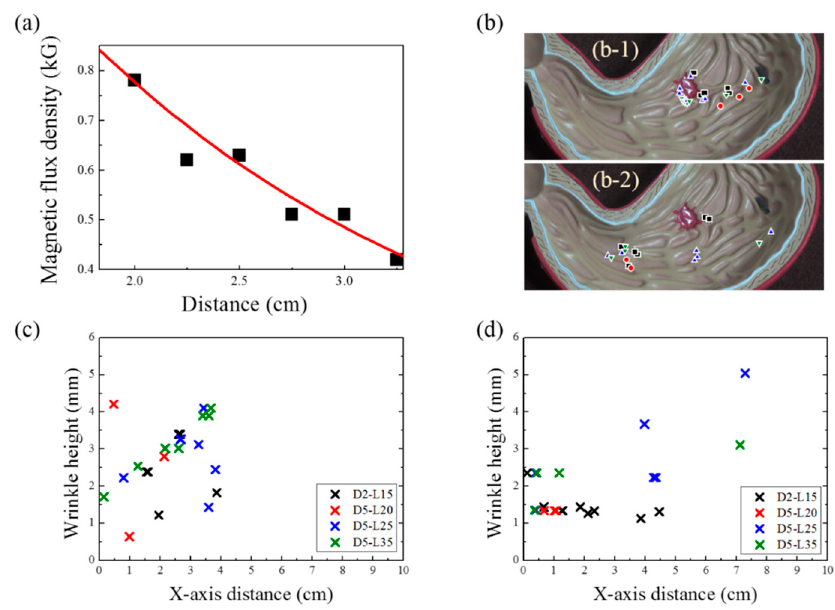
Figure 6. ( a ) Variation in magnetic-flux density with respect to the distance between the magnet and the samples; ( b ) Cessation location of magnetic actuation indicated by the X symbol for esophagus departure (1) and duodenum departure (2) cases; ( c ) Wrinkle height and X-axis distance where the soft-robot magnetic actuation ceased in the case of esophagus departure; ( d ) Wrinkle height and X-axis distance where the soft-robot magnetic actuation ceased in the case of duodenum departure.